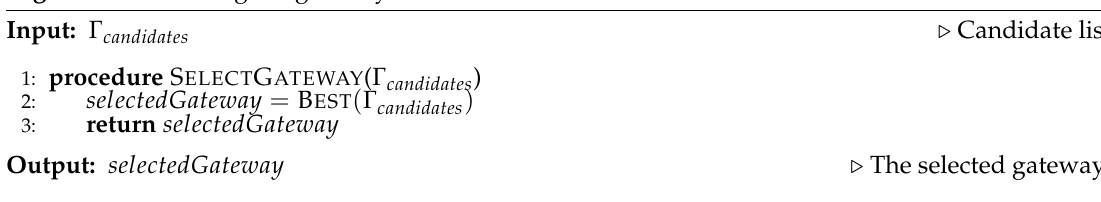
Algorithm 3 Selecting the gateway to